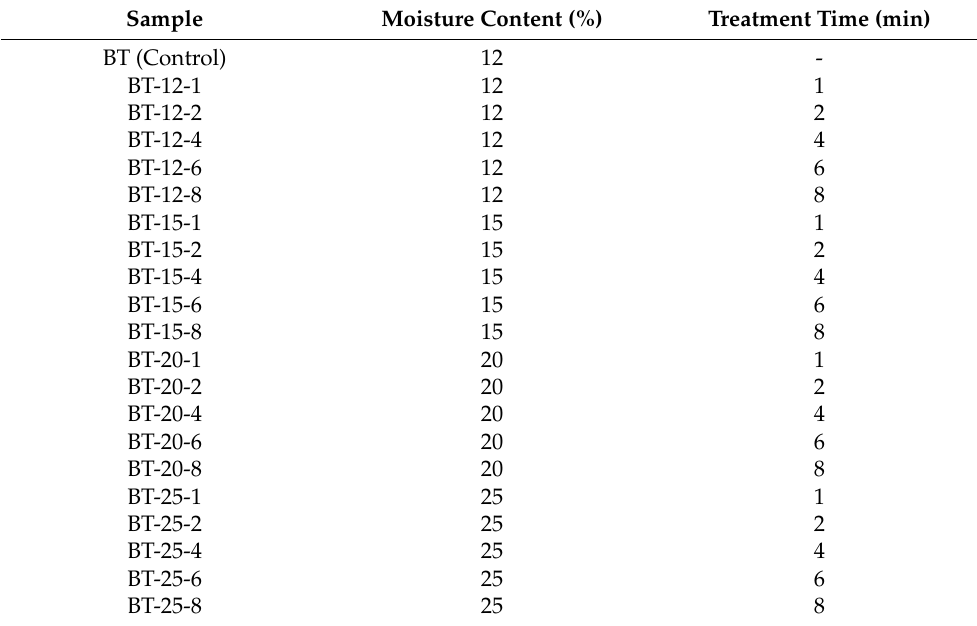
Table 1. Microwave treatment conditions and identification of samples.